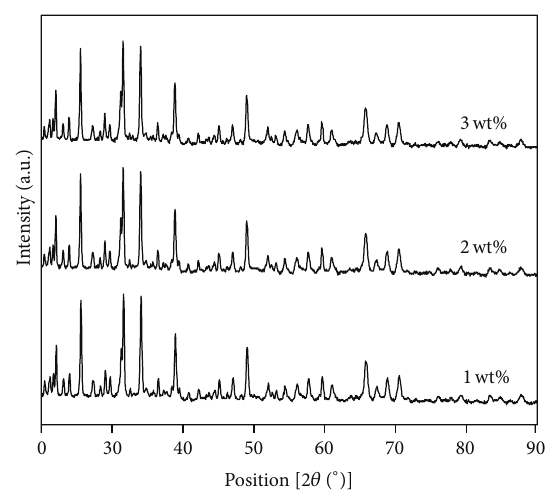
Figure 2: A variation of sintering temperature with linear shrinkage of Eu 2 O 3 doped willemite-based glass ceramic.